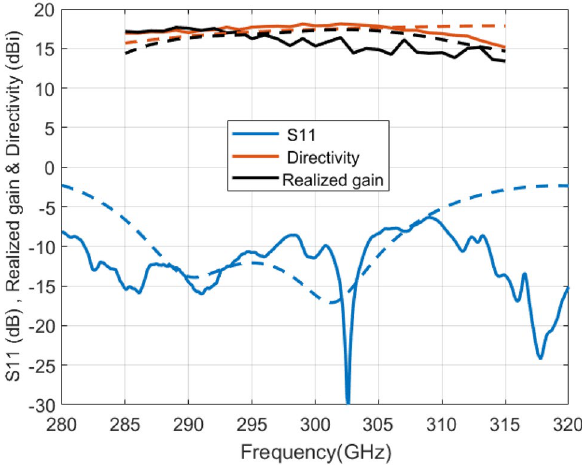
Figure 7. Measured (solid lines) and simulated (dashed lines) of (S11), directivity and realized gain for 300 GHz FPC antenna prototype.